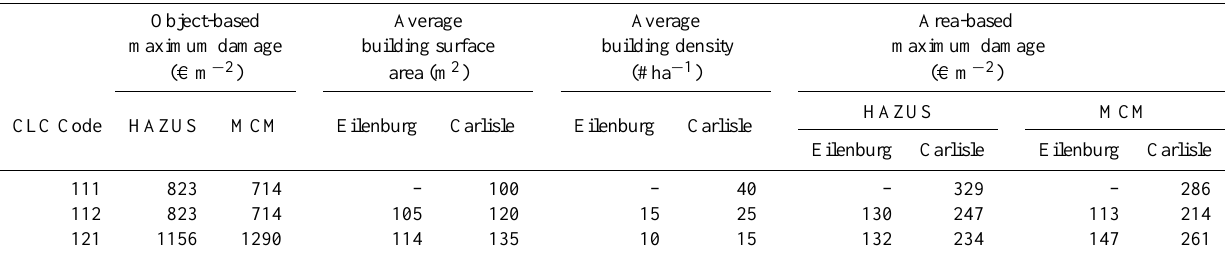
Table 2. Conversion of original object-based maximum damage values of HAZUS and MCM (left) to area-based values (right), on the basis of average building densities and surface areas for Eilenburg and Carlisle. Building densities and surface area estimates are derived from a spatial dataset of individual buildings for Eilenburg and 1m × 1m resolution MasterMap®data for Carlisle, specifically for the areas in the simulated inundation zones (Fig.